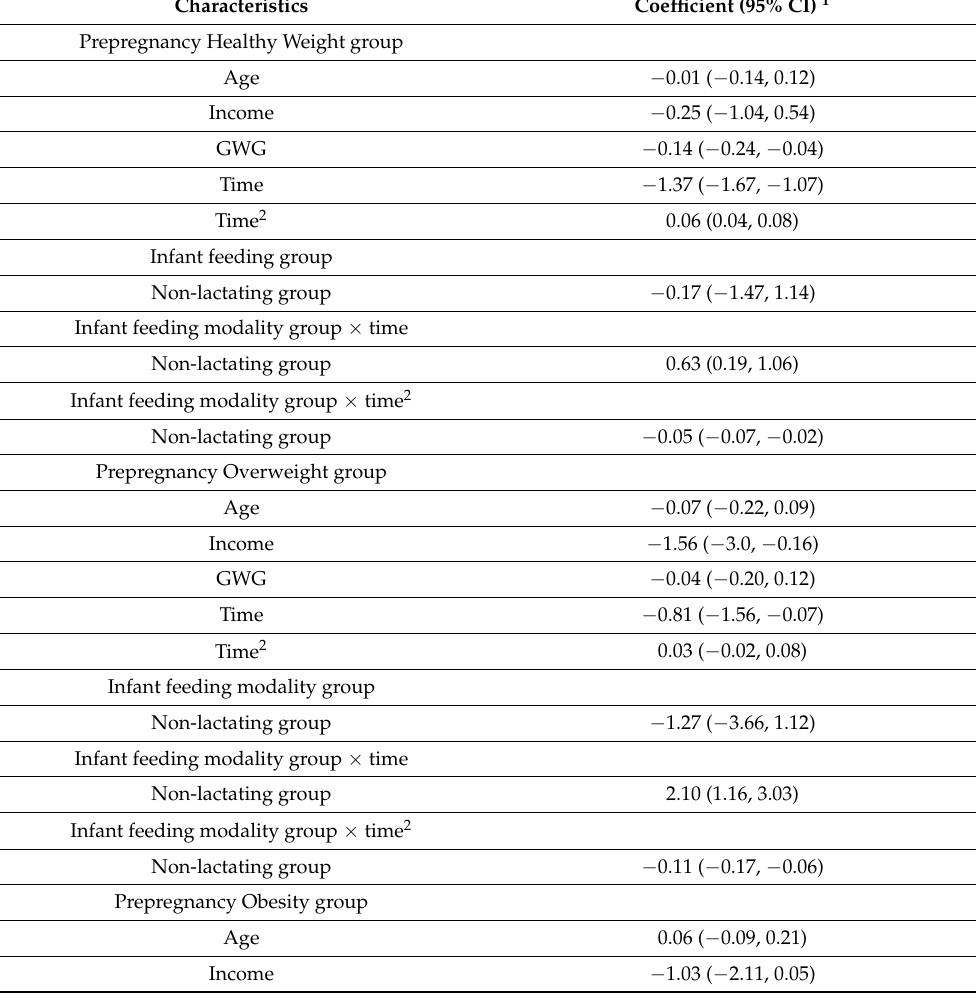
Table 2. Outputs from the linear mixed-effects models on influence of infant feeding modality on